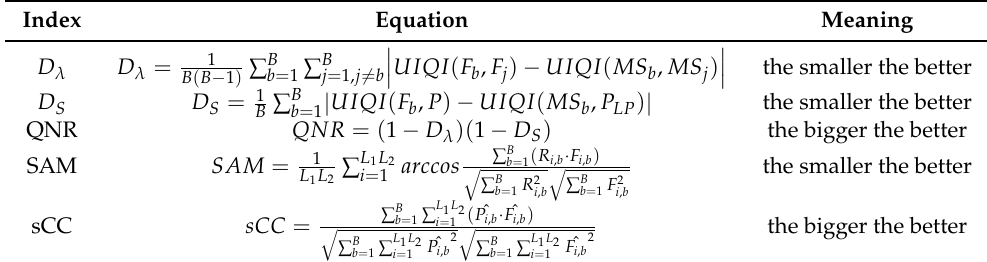
Table 3. Quality